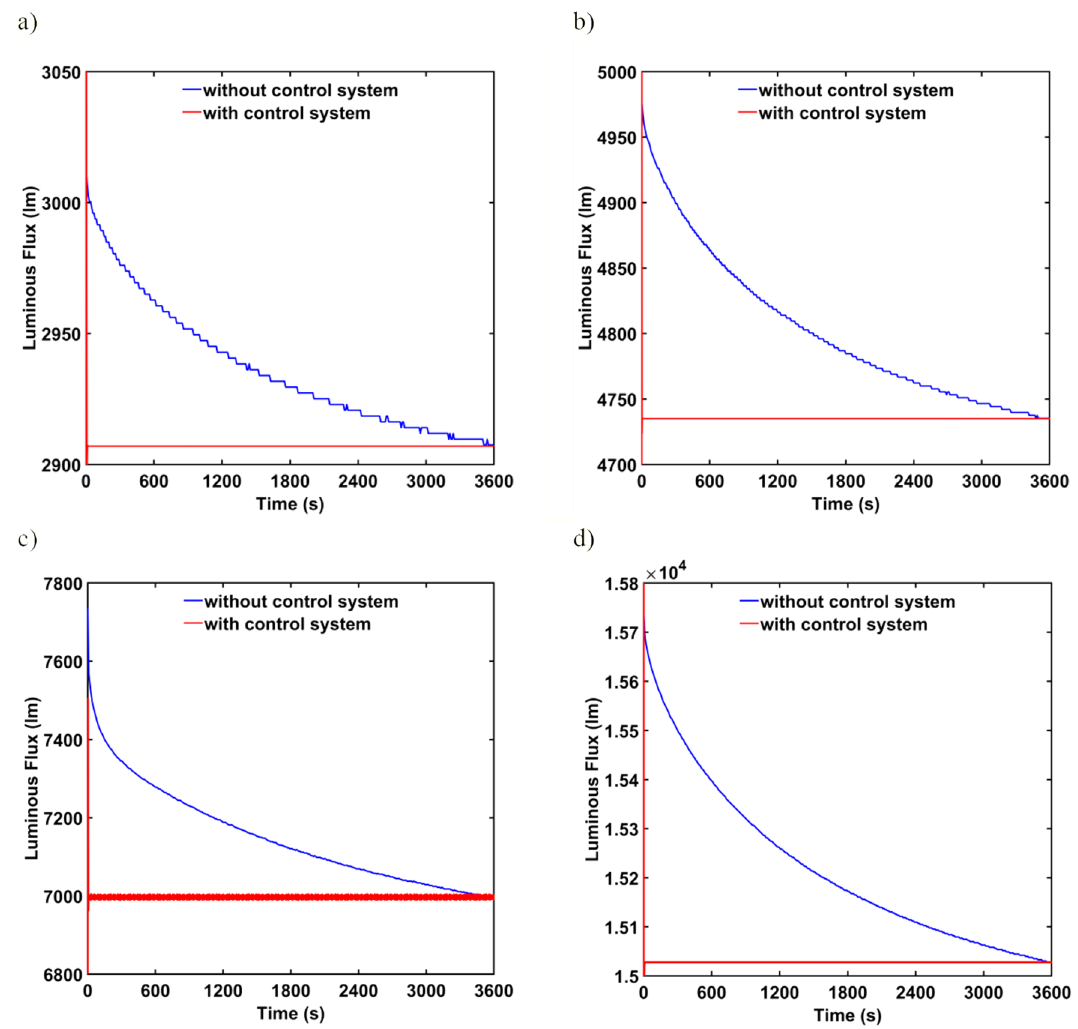
Figure 6. Control of ( a ) L1 lumianire, ( b ) L2 luminaire, ( c ) L3 luminaire, ( d ) L4